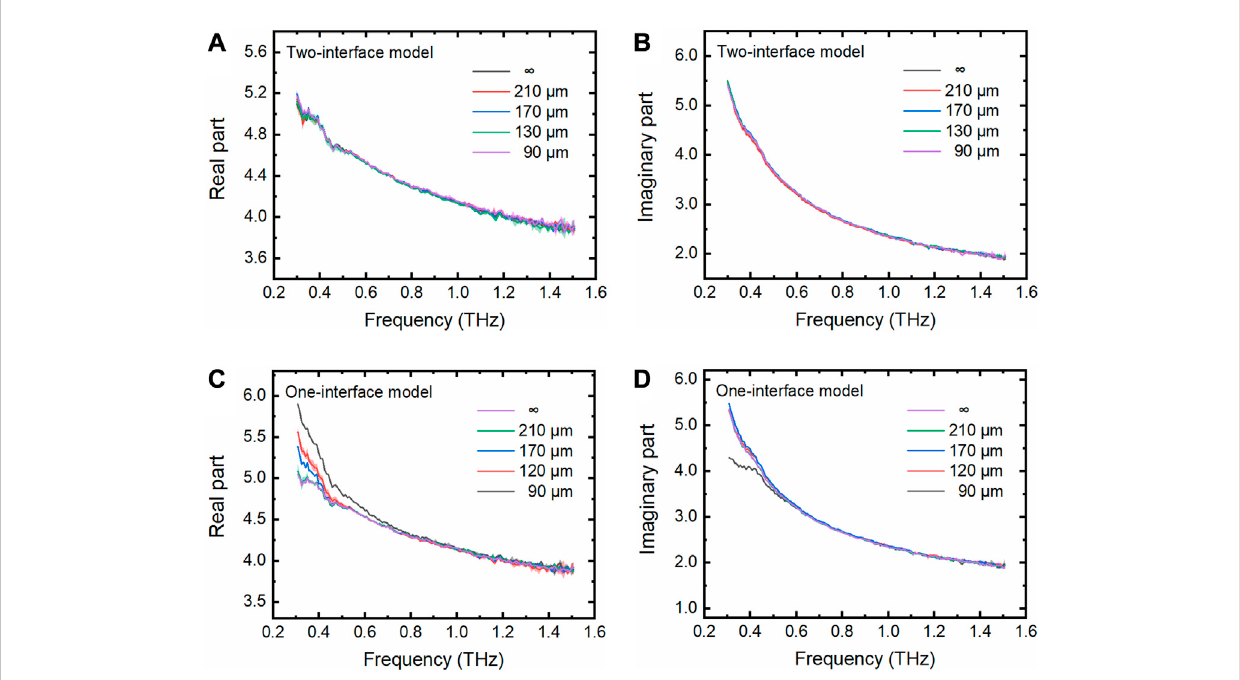
FIGURE 3 THz spectraofpurewater measuredusingtheTHz TD-ATRmicro fl uidicsystem. (A – B) Realand imaginary partsofthecomplexdielectricconstants of pure water fi lled in the M-chips with various depths (90, 130, 170, and 210 μ m) and the in fi nite thickness relative to the penetration depth of the evanescent waves, denoted by “ ∞ ” , which were extracted by the two-interface model. (C – D) These parameters were extracted by the one-interface model. The semitransparent homochromic shadows around the lines represent the standard deviation (SD) of three independent